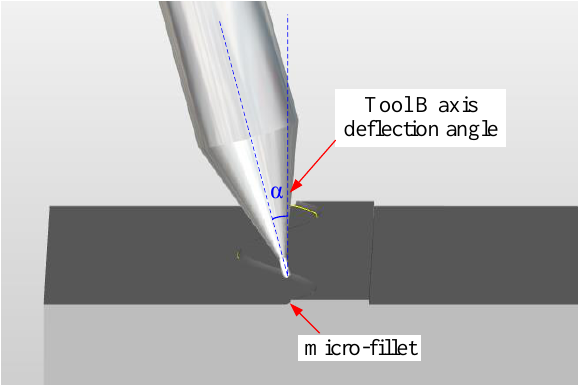
Figure 9. Tool path of tool B-axis deflection angle.